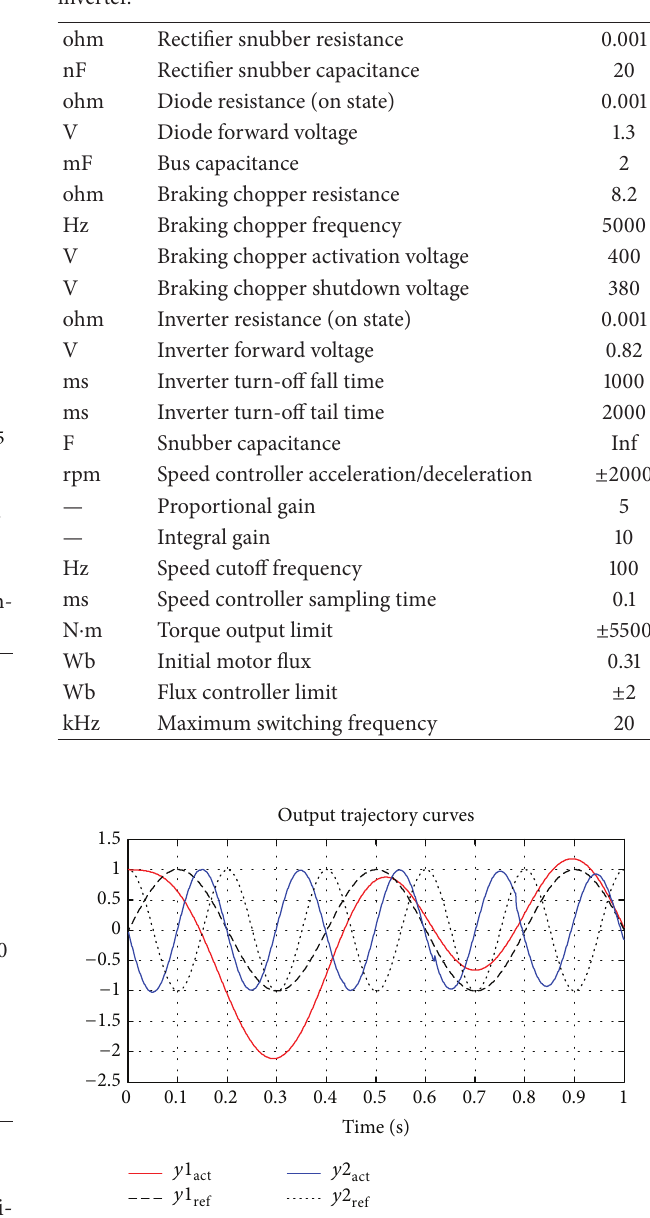
Figure 6: Feedback tracking control of two output